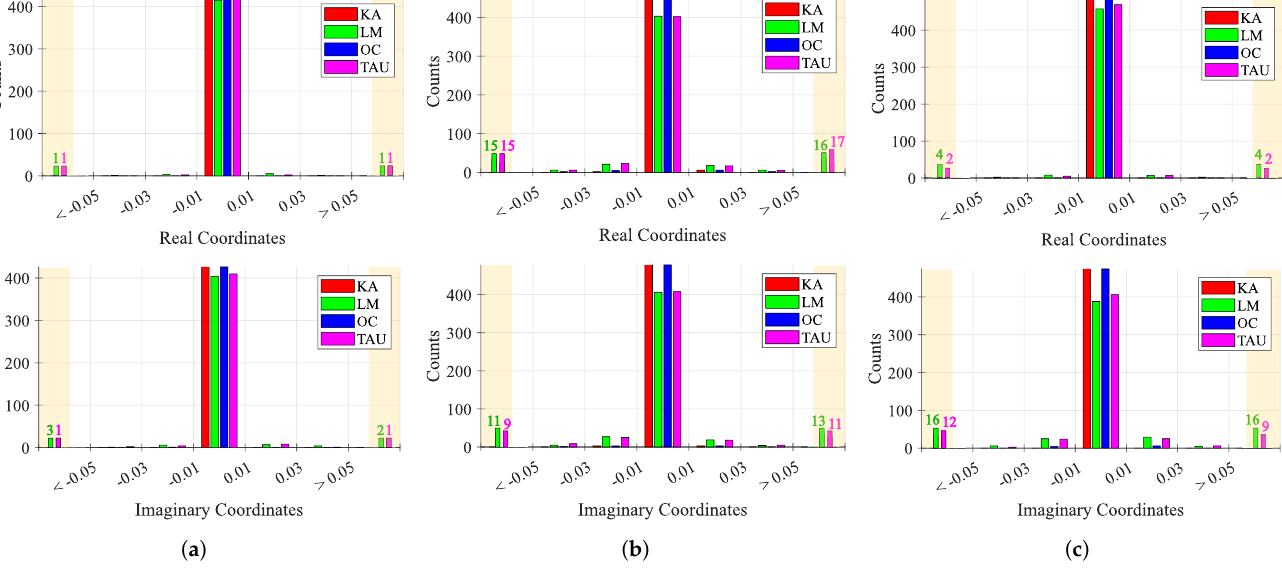
Figure 15. Histogram of the behavior of consecutive estimations ∆ C over time: ( a ) Case 1, ( b ) Case 2, ( c ) Case